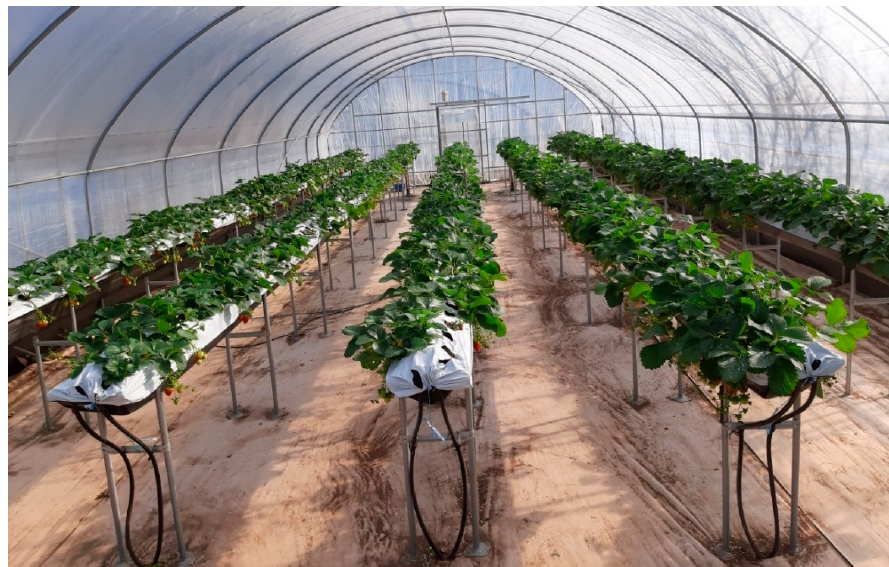
Figure 1. Experimental greenhouse for strawberry cultivation. For collecting the fruit samples of each strawberry cultivar, harvesting was per- formed at six distinct ripening stages, i.e., Dark red, Bright red, Three-quarter red, Half red, Turning and Whiting. The ripening stages were identified and divided according to the development of color on the skin, which ranged from dark red (final stage) to white (initial stage) [6]. For the measurement of biometrical parameters, i.e., length, diameter, and fresh weight, 50 fruit samples were collected in each ripening stage of strawberry cultivars. 2.2. Measurement of Biometrical Characteristics The fruit sample was cleaned with distilled water, drained and followed by cleaning with the use of paper towels to remove extra water from their surface before the measure- ment of length, diameter, and fresh weight. A total of 300 samples of each cultivar were used to determine their length, diameter and fresh weight. The fresh weight of each straw- berry (in g) was measured using a digital balance (FX-300iWP, A&D Company Ltd., To- kyo, Japan), whereas the diameter and stem length (in mm) were measured by using a digital Vernier caliper (Model: E03-150 122-521, Datac Co., Ltd., Seoul, Korea). 2.3. Image Acquisition of Strawberry Fruits Each strawberry sample’s image was acquired using a laboratory-based imaging sys- tem (Figure 2). A rectangular light chamber of dimension (80 80 80 cm) was used as studio to capture an image of each fruit sample using a camera setup (SONY DSC-RX100 vii, Sony, Seoul, Korea). The acquired image was in RGB format with resolution of 5472 × 3648 pixels. The light chamber consists of dual light-emitting diodes (LED) strips, where each strip of lamps had a 10 W total light emitting capacity [3]. In order to prevent shad- ows on the strawberry and to obtain a high-quality image, the interior of the light chamber (with the exception of the bottom surface) was made of an aluminum surface. To create a uniform background, the bottom surface of the light chamber was made of a black surface. The sample was placed at a fixed distance of 80 cm from the camera lens. Estimation of pixel numbers from spherical or quasi-spherical images is quite easy because they have a strong correlation with some dimensional parameters of the 2D projected region [48]; however, it is very hard to calculate for strawberries due to its natural irregularities in shape. In order to minimize this limitation, we captured images of each strawberry on